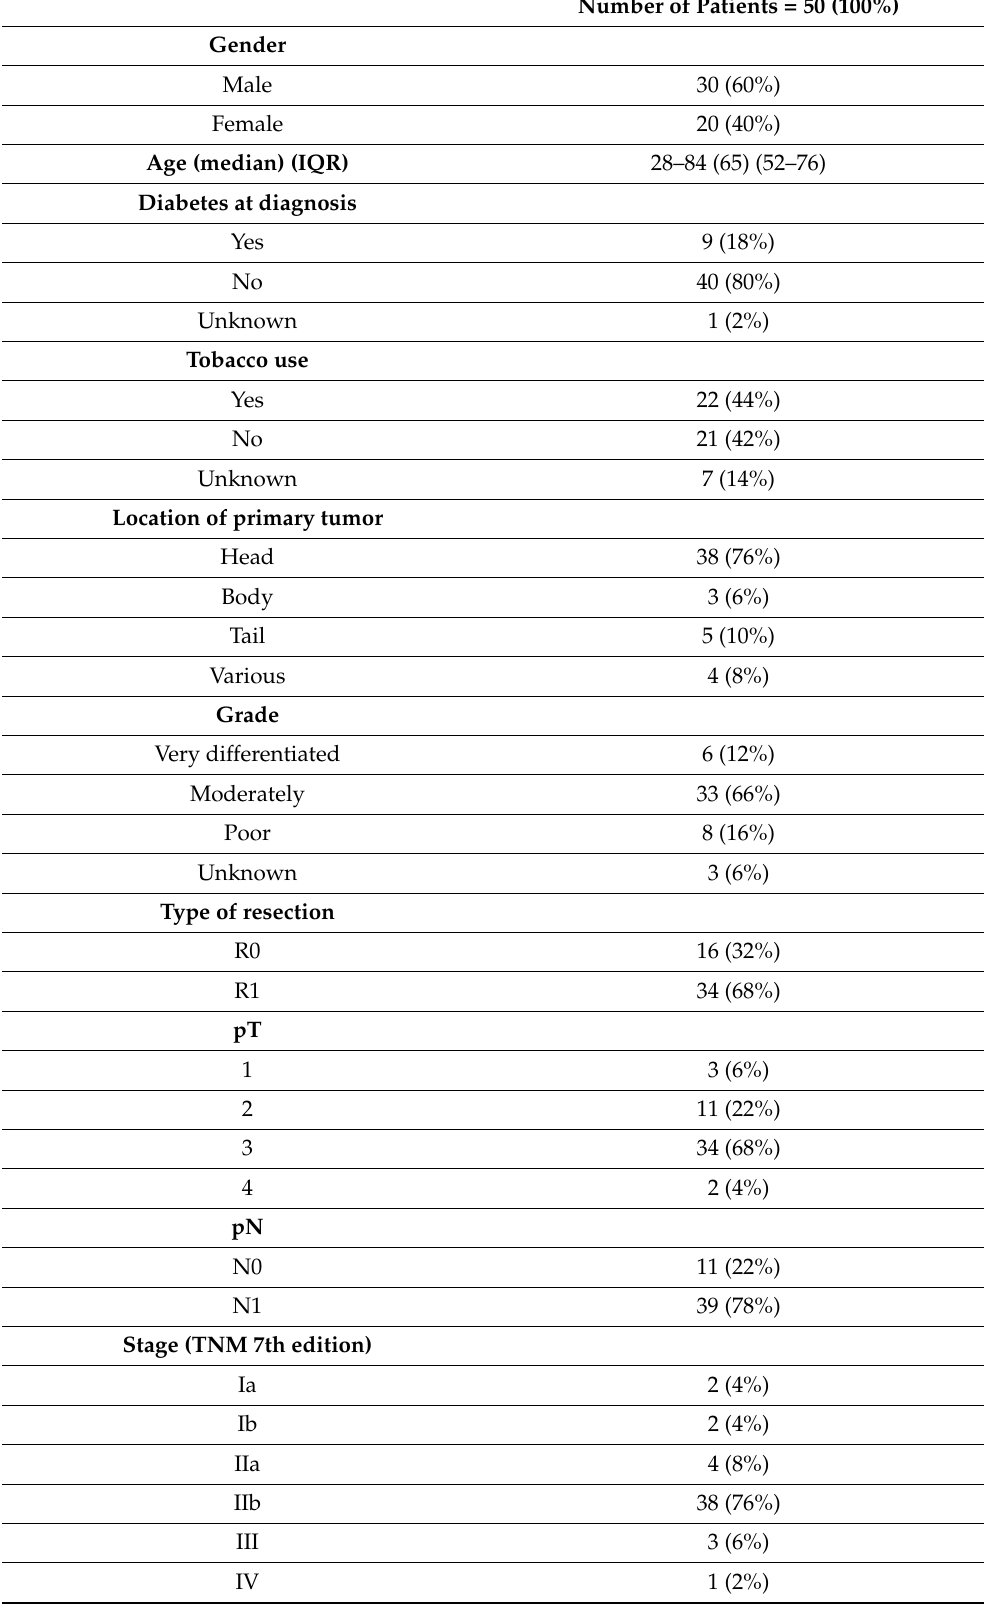
Table 1. Patients’